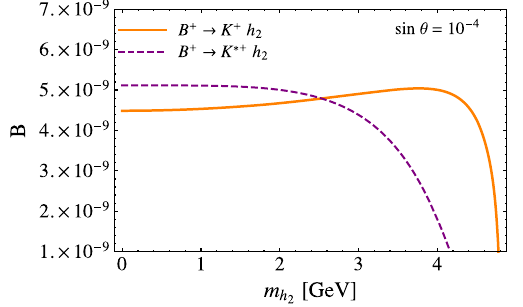
Fig. 2 Comparison of the branching fractions of B + → K + h 2 (thick orange curve) and B + → K ∗+ h 2 (dashed purple curve) for sin θ = 10 −